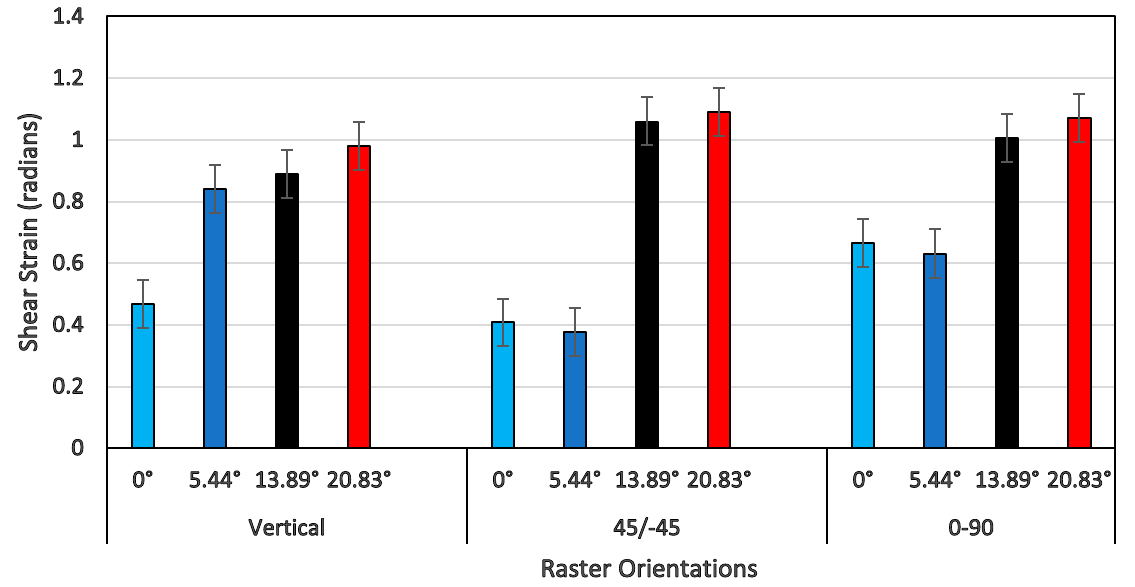
Figure 14. Shearing strain of the shear zone endpoints (in radians) with their respective raster orientations and shear angles.